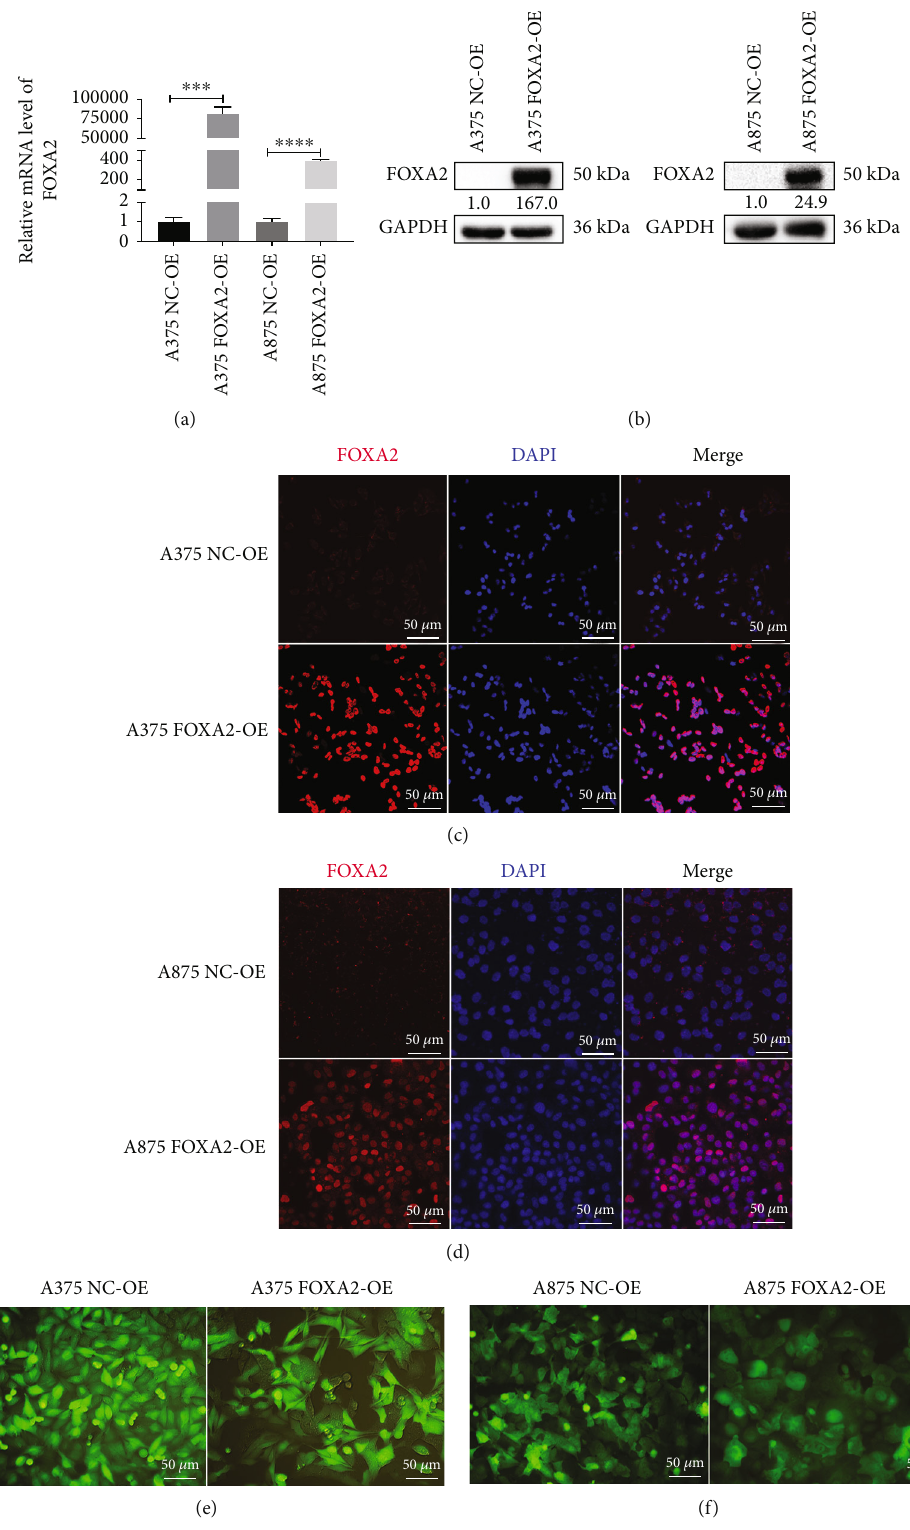
Figure 6: Establishment and identi fi cation of FOXA2 overexpression in melanoma cell lines. (a) RT-qPCR analysis of the relative mRNA expression of FOXA2 in NC-OE and FOXA2-OE melanoma cells. (b) Western blotting analysis of the protein expression of FOXA2 in NC-OE and FOXA2-OE melanoma cells. (c, d) Representative images of immuno fl uorescence staining for FOXA2 in NC-OE and FOXA2-OE melanoma cells. (e, f) Representative fi gures show that FOXA2-OE melanoma cells were more cohesive and spatially organized than NC-OE cells. Scale bars = 50 μ m. ∗∗∗ p < 0 : 001 , ∗∗∗∗ p < 0 : 0001 vs. control